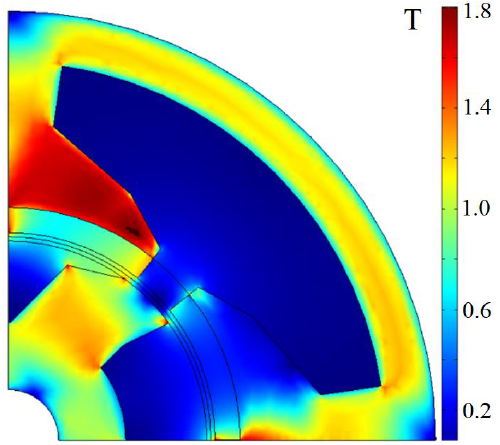
Figure 11. Motor design and simultaneous flux density field (T) in the FRM after second optimization. Table 5. The FRM parameters varied during the second optimization. After first optimization After second optimization (Figure Parameter (Figure 3b) Number of turns per phase